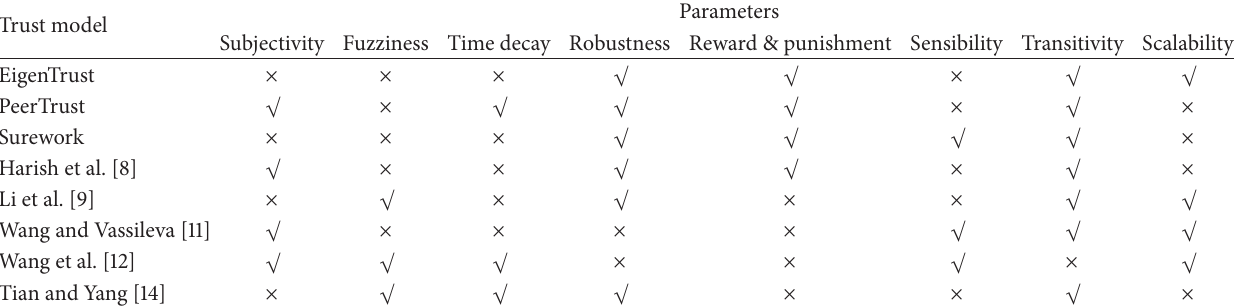
Table 1: The distribution of parameters of some P2P trust